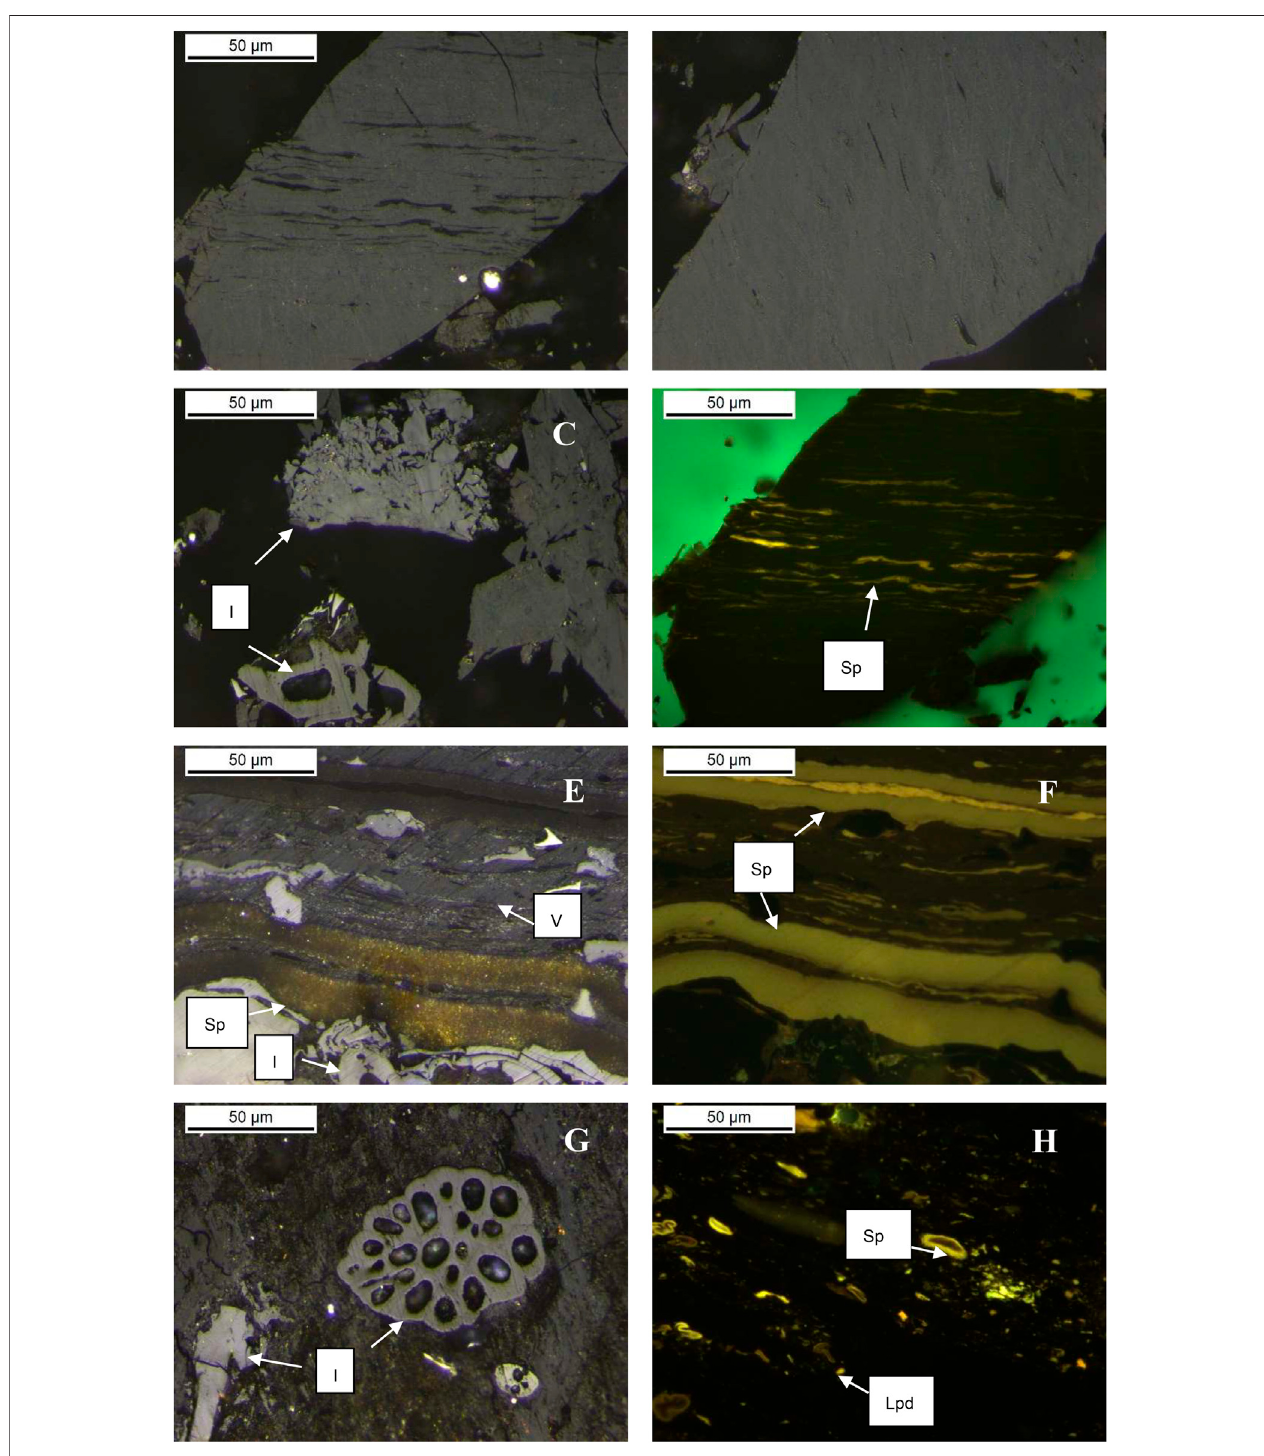
FIGURE3| Photomicrographsofspring fi eldcoal#1[Panels (A – D) ; (A – C) ,re fl ectedlight,oil-immersion; (D) , fl uorescentlight],spring fi eldcoal#2[Panels (E,F) ; (E) , re fl ected light; (F) , fl uorescent light], and Wilcox Coal [Panels (G,H) ] under the microscope. Abbreviations: V – vitrinite, Sp – sporinite, I – inertinite, Lpd – liptodetrinite.